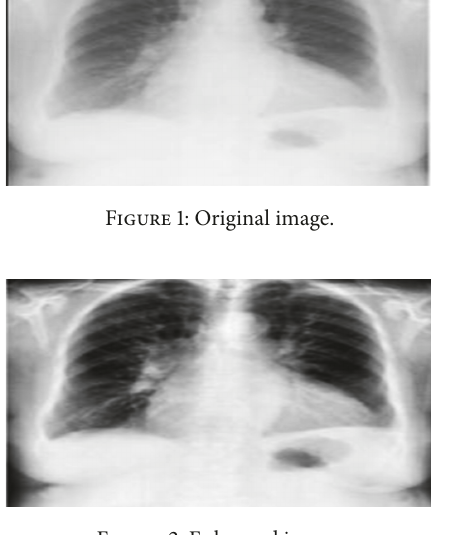
Figure 2: Enhanced image.